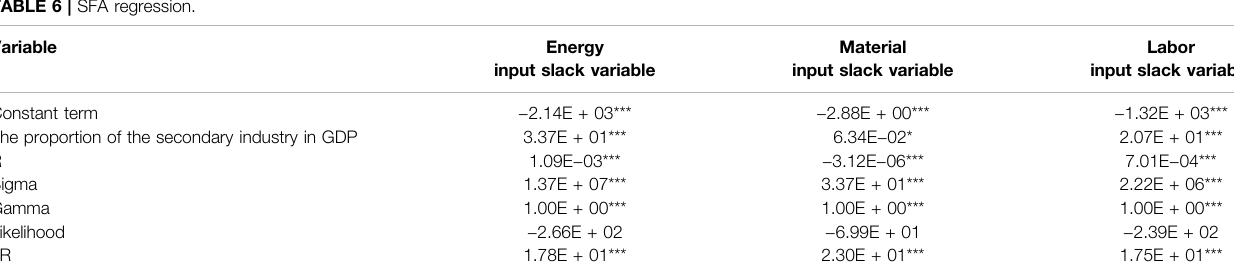
TABLE 6 | SFA regression. Variable